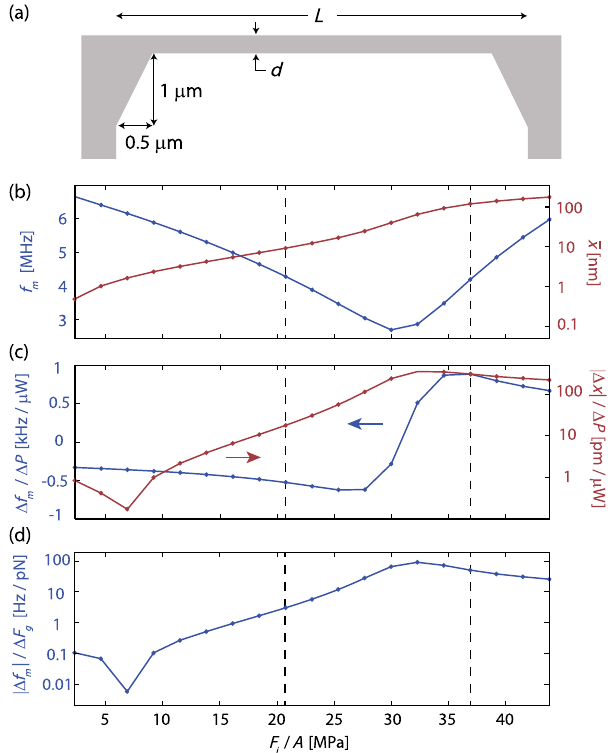
FIG. 12. (a) Longitudinal cross section of nanobeam used in ANSYS finite element simulations, showing the “ arched ” clamping- point geometry. (b) Finite element simulations of resonance frequency and nanobeam deflection as a function of axial com- pressive stress. Dashed lines indicate value of F where simulated i ω approximately matches the experimentally observed value. m (c) Simulated change in resonance frequency and nanobeam ¼ 1 μ W of absorbed optical power. (d) Simu- deflection for P abs ¼ 1 pN transverse lated change in resonance frequency from a F g load applied across the coupling region of the nanobeam (length L ). Nanobeam dimensions are L × w × d ¼ 80 × 0 . 48 × 0 . 25 μ m 3 , c as in the self-oscillation